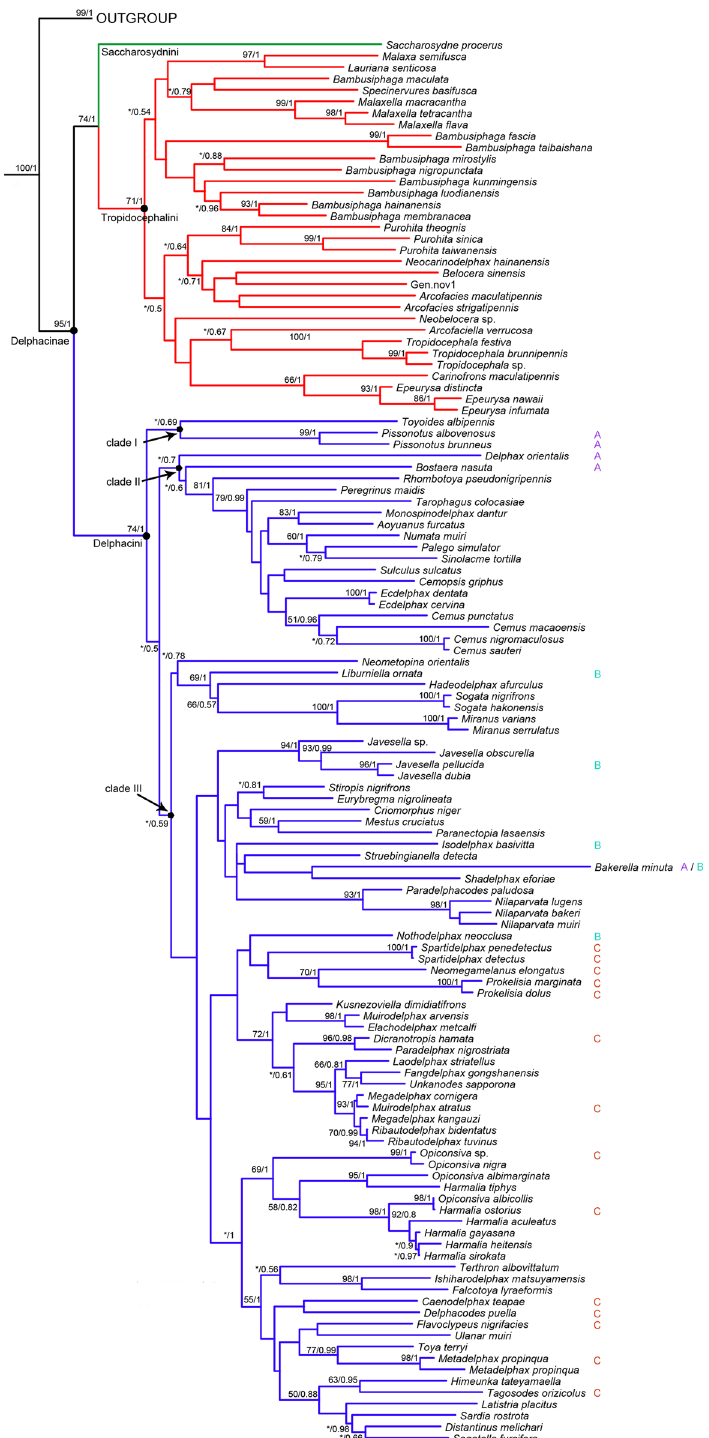
Figure 1. Phylogenetic tree of Delphacinae obtained from maximum likelihood (ML) analysis based on concatenated data of genes cox1 , cytb , 16S rDNA and 28S rDNA. ML bootstrap values and Bayesian posterior probabilities are indicated at internal nodes. Bootstrap values under 50 are replaced by “ * ”. The species acquired from Urban et al . were indicated with A, B, C as belonging to clade 1, 2 and 3 in their research,